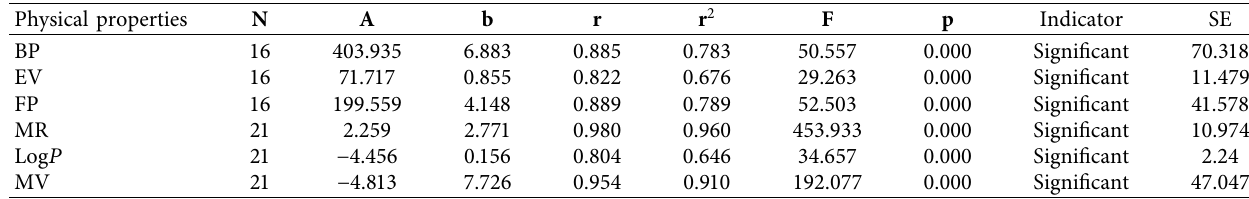
Table 13: Statistical specifications for the linear model of IS ( G ) .